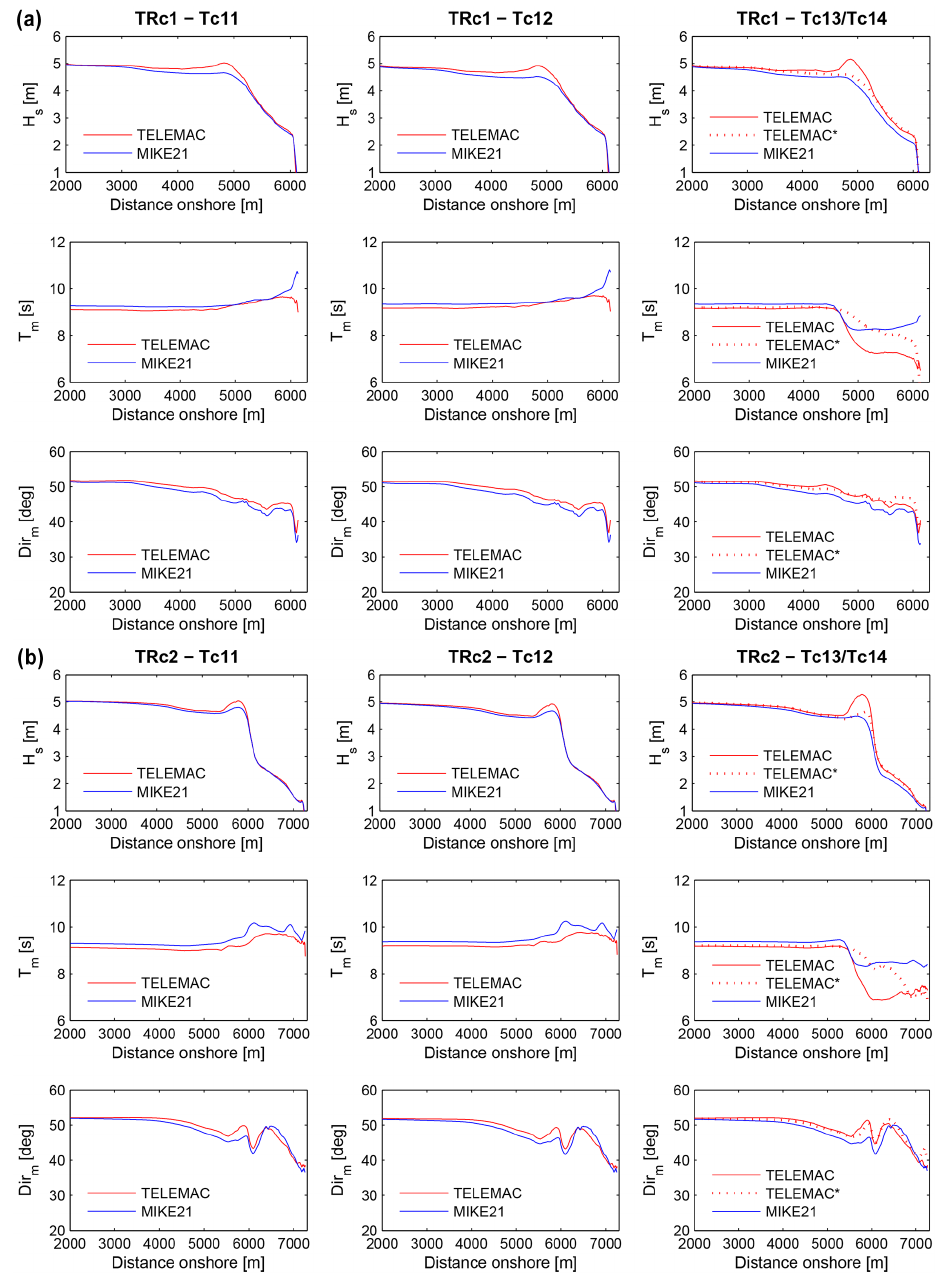
Figure 5. Comparison of TELEMAC and MIKE21 results ( H s − T m − Dir m ) along transects (a) TRc1 and (b) TRc2, for the Brindisi–Torre Guaceto case study (forcing WE1; ∗ =